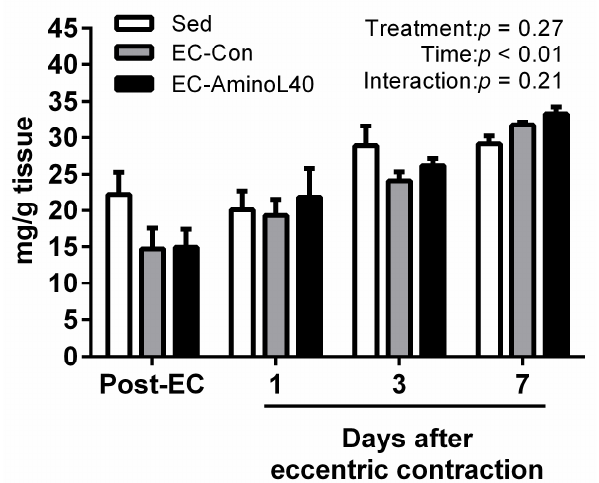
Figure 4. Phosphocreatine (PCr) content in the tibialis anterior (TA) muscle immediately after eccentric contraction (Post-EC), 1, 3, and 7 days later. PCr content was measured in the sedentary group (Sed), and in rats who underwent eccentric contractions and were given water (EC-Con) or a leucine-enriched essential amino acids mixture (EC-AminoL40). Data represent the mean ± SEM ( n = 4 (Sed) or 5 (EC groups)).